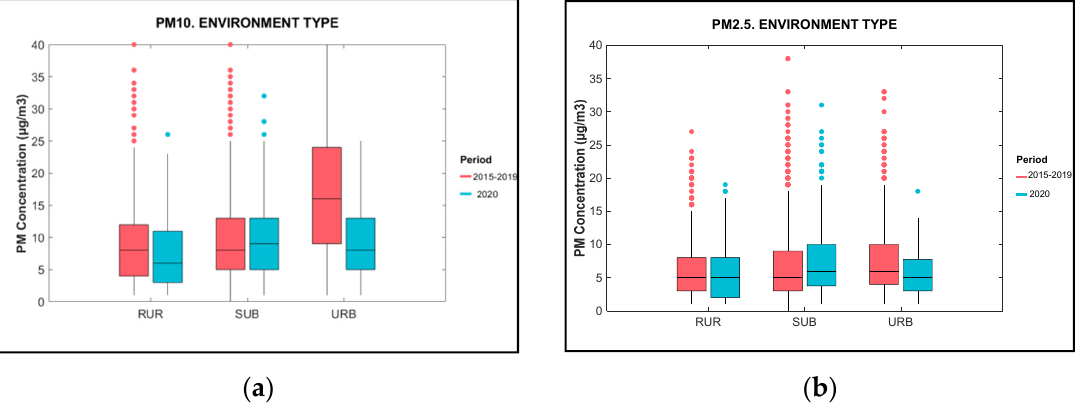
Figure 4. ( a , b ) Box plots by environment type. ( a , b ) represent PM 10 and PM 2.5 respectively in the reference and the lockdown periods. The marker inside the boxplot is the median, and lower and upper box boundaries are the 25th (Q1) and 75th (Q3) percentiles, respectively. Lower and upper whiskers represent Q1 − 1.5·IQR and Q3 + 1.5·IQR, respectively. Dots are outliers.